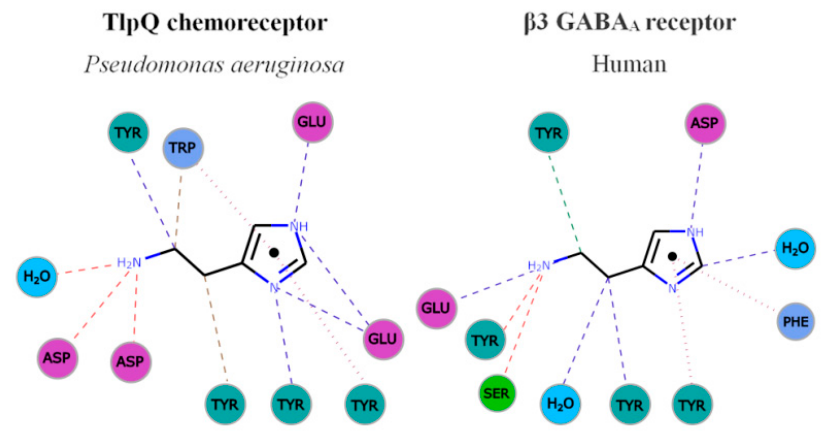
Figure 3. Parallelism in the mode of histamine recognition by P. aeruginosa TlpQ-LBD and the human β 3 GABA A receptor. The interaction of histamine within the different binding pocket was automatically generated at the PDBe, using Arpeggio [71]. Non-covalent interactions are shown by the following colored dashed lines: red, hydrogen bonds; green, hydrophobic interactions; brown, weak hydrogen bonds; and purple, pi-pi interactions. The thickness of each dash is related to the interaction-distance. Hydrophobic, negatively charged, aromatic and polar residues are colored in blue, magenta, green and cyan, respectively. For clarity, only some representative interactions are shown.